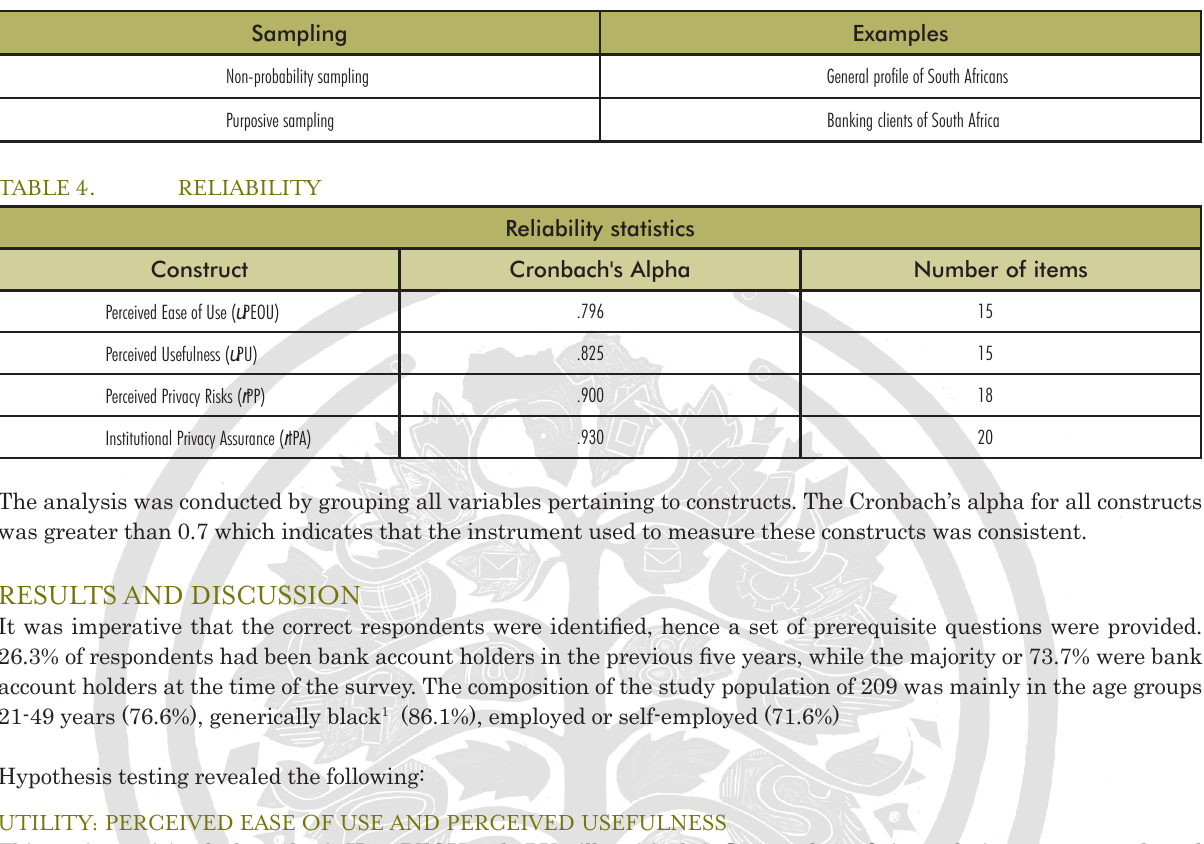
C uPEOU uPU Banking and file sharing